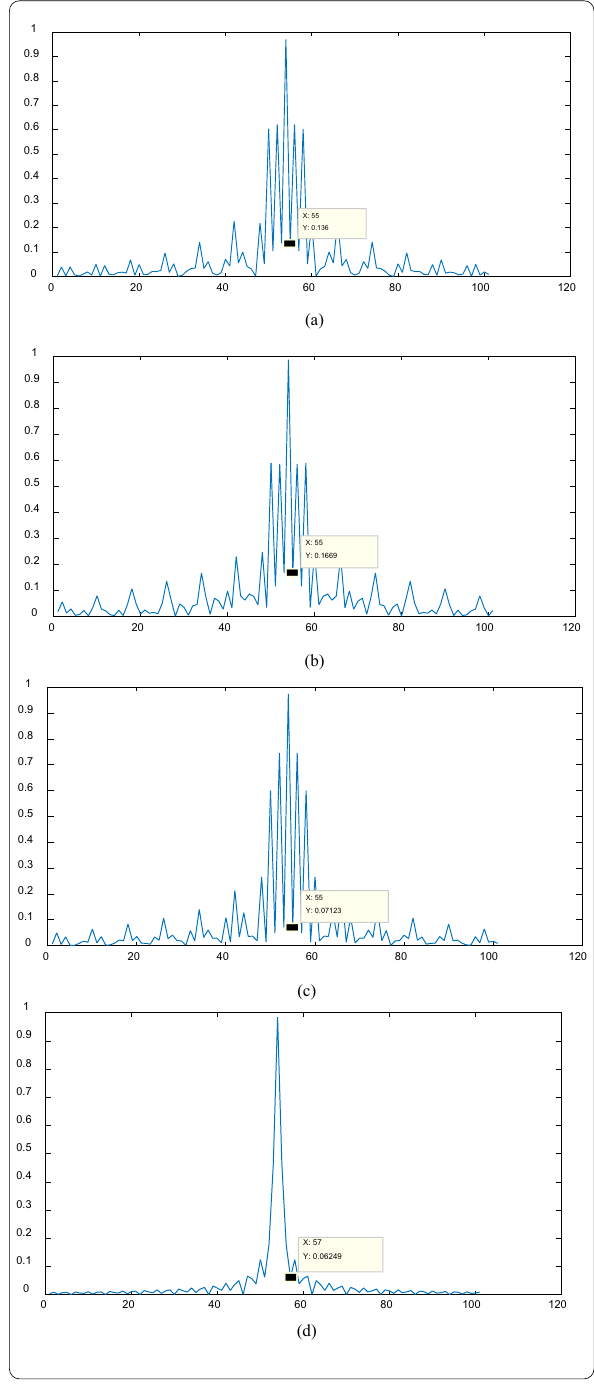
Fig. 2 a The PSF for the aperture shown in the Fig. 1a, in the range from 460 to 560 pixels. The cut‑off for the central lope 55 pixels = while the central peak at 54 pixels. FWHM 1 pixels. b The PSF for = the aperture shown in the Fig. 1b, in the range from 460 to 560 pixels. The cut‑off for the central lope 55 pixels while the central peak = at 54 pixels. FWHM 1 pixels. c The PSF for the aperture shown in = the Fig. 1c, in the range from 460 to 560 pixels. The cut‑off for the central lope 55 pixels while the central peak at 54 pixels. FWHM 1 = = pixels. The side lobes are strengthen compared with that shown in the figure ( b ). d The PSF for the whole aperture shown in the Fig. 1d, in the same range as in the figure ( b ). The cut‑off for the central lope 57 pixels while the central peak at 54 pixels. FWHM 3 = =